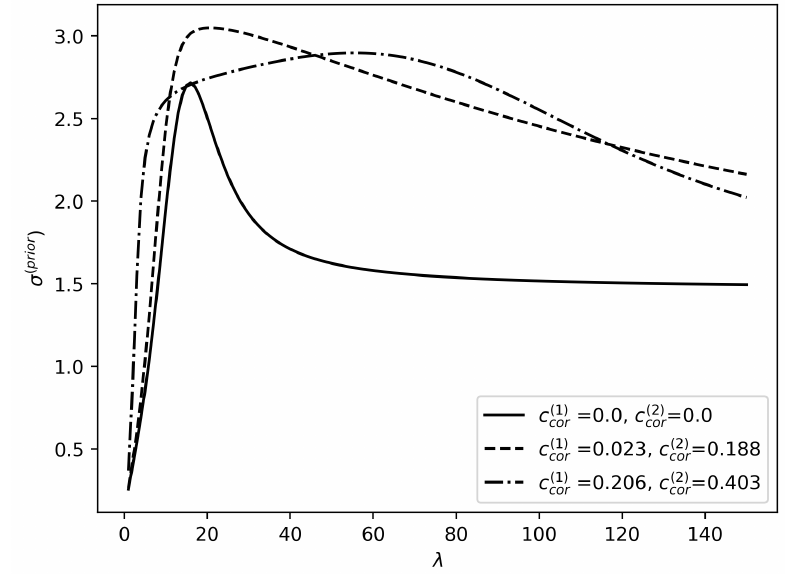
Figure 10. The standard deviations σ ( prior ) of the number of priority customers in the buffer for the BMMAP s with different coefficients of